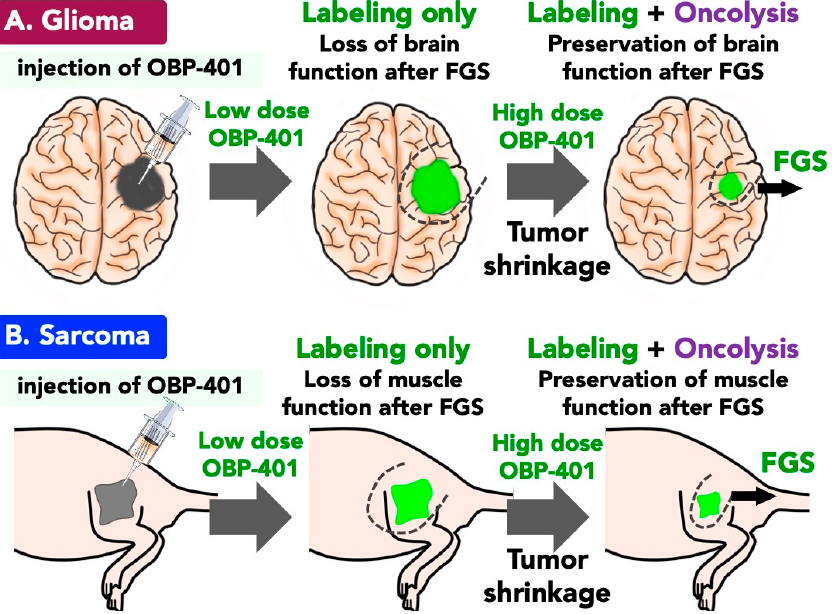
Figure 3. OBP-401-GFP mediated fluorescence-guided surgery (FGS) with preservation of function. ( A ) FGS for glioblastoma (GBM) with OBP-401-mediated bright GFP tumor labeling and oncolysis. Whole-tumor imaging with an orthotopic GBM mouse model demonstrated that low-dose OBP-401 labels GBM tumors with GFP and clearly highlights the margin between the GBM and normal brain tissue, which enables FGS with partial loss of brain function. High-dose OBP-401 shrinks the GBM tumor, then enables effective FGS with preservation of function. ( B ) FGS for soft tissue sarcoma (STS) with OBP-401-mediated bright GFP tumor labeling and oncolysis. Whole-tumor imaging with an orthotopic STS mouse model demonstrated that low-dose OBP-401 labels STS tumors with GFP, clearly highlights the margin between the STS tumor and normal muscle or fat tissue, and consequently enables FGS partly with partial loss of motor function. High-dose OBP-401 shrinks the STS tumor, then enables effective FGS with preservation of motor